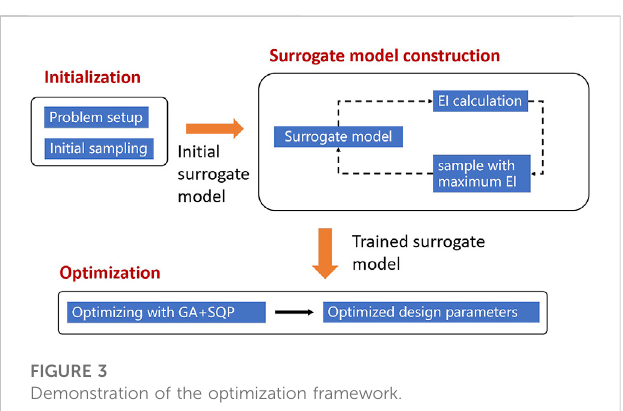
FIGURE 3 Demonstration of the optimization framework.